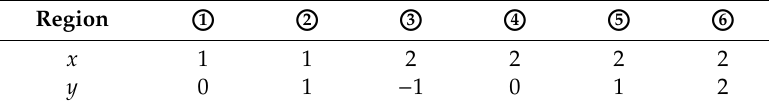
Table 2. The values of x and y corresponding to each